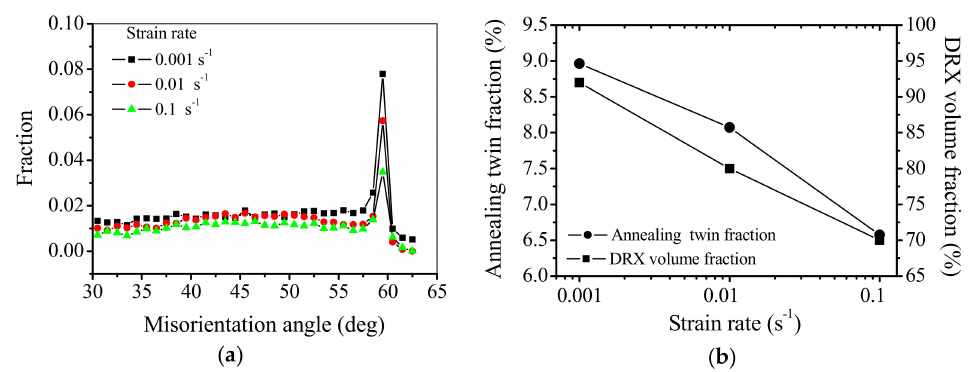
Figure 9. Changes of annealing twin fraction and DRX volume fraction at the strain and the de- formation temperature are 1.2 and 1253 K, respectively. ( a ) Misorientation angle distribution and ( b ) variations of annealing twin fraction and DRX volume fraction with strain rate.